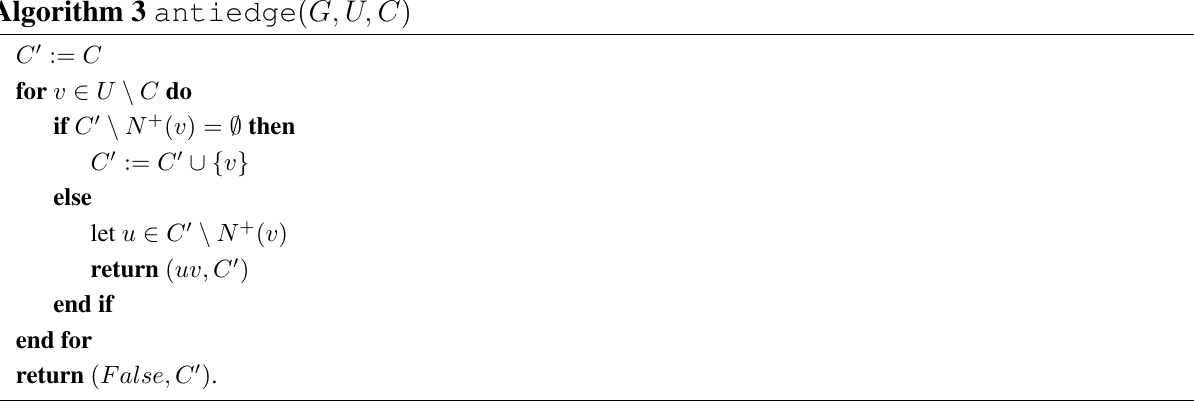
Algorithm 3 antiedge ( G, U, C